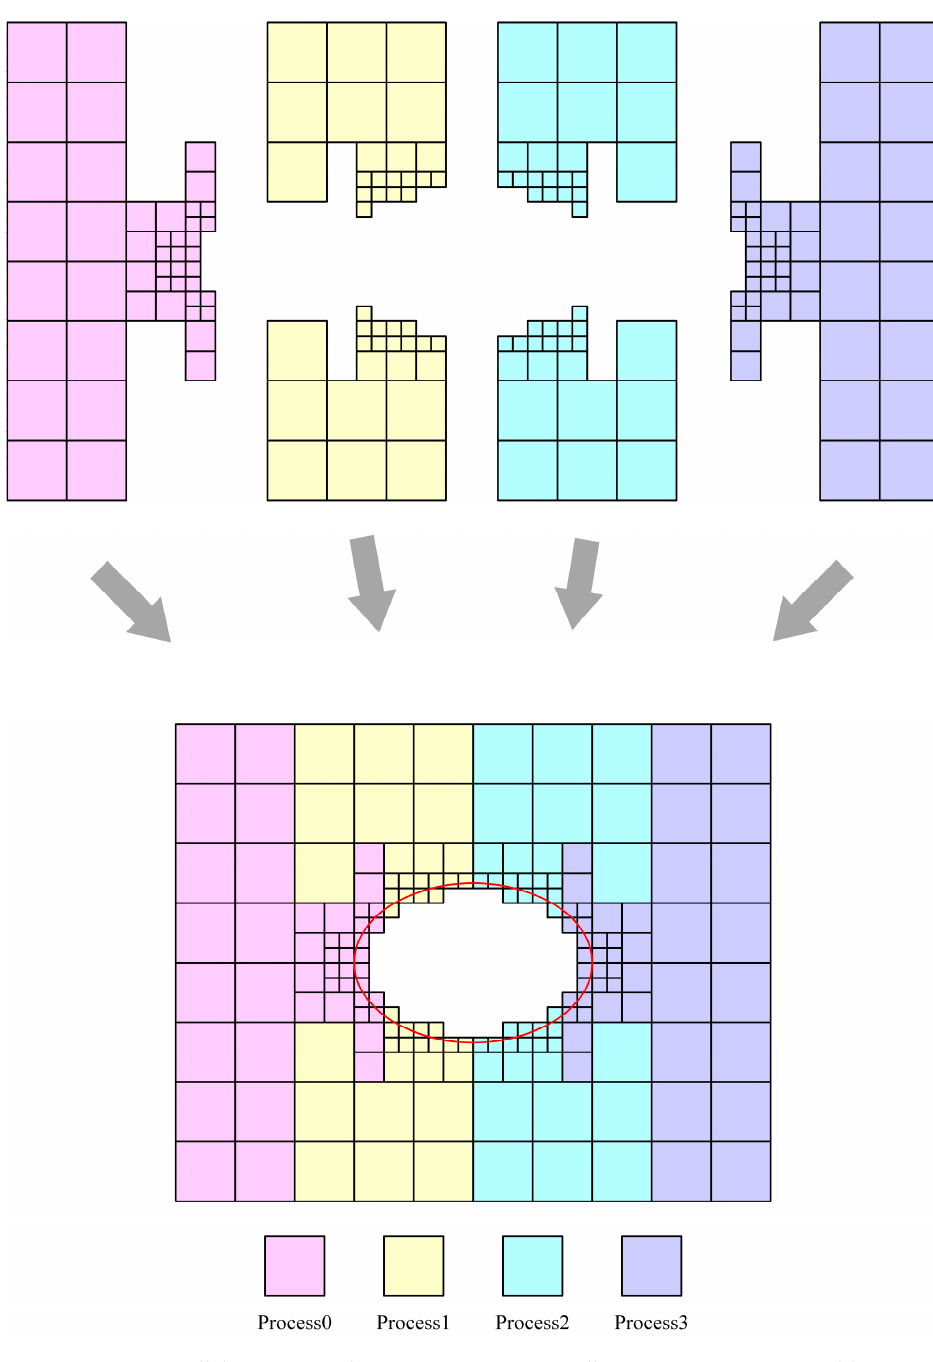
Figure 12. MPI parallel strategy: red represents process 0, yellow represents process 1, blue represents process 2 and purple represents process 3. The red ellipse circle indicates the solid boundary in the flow field.